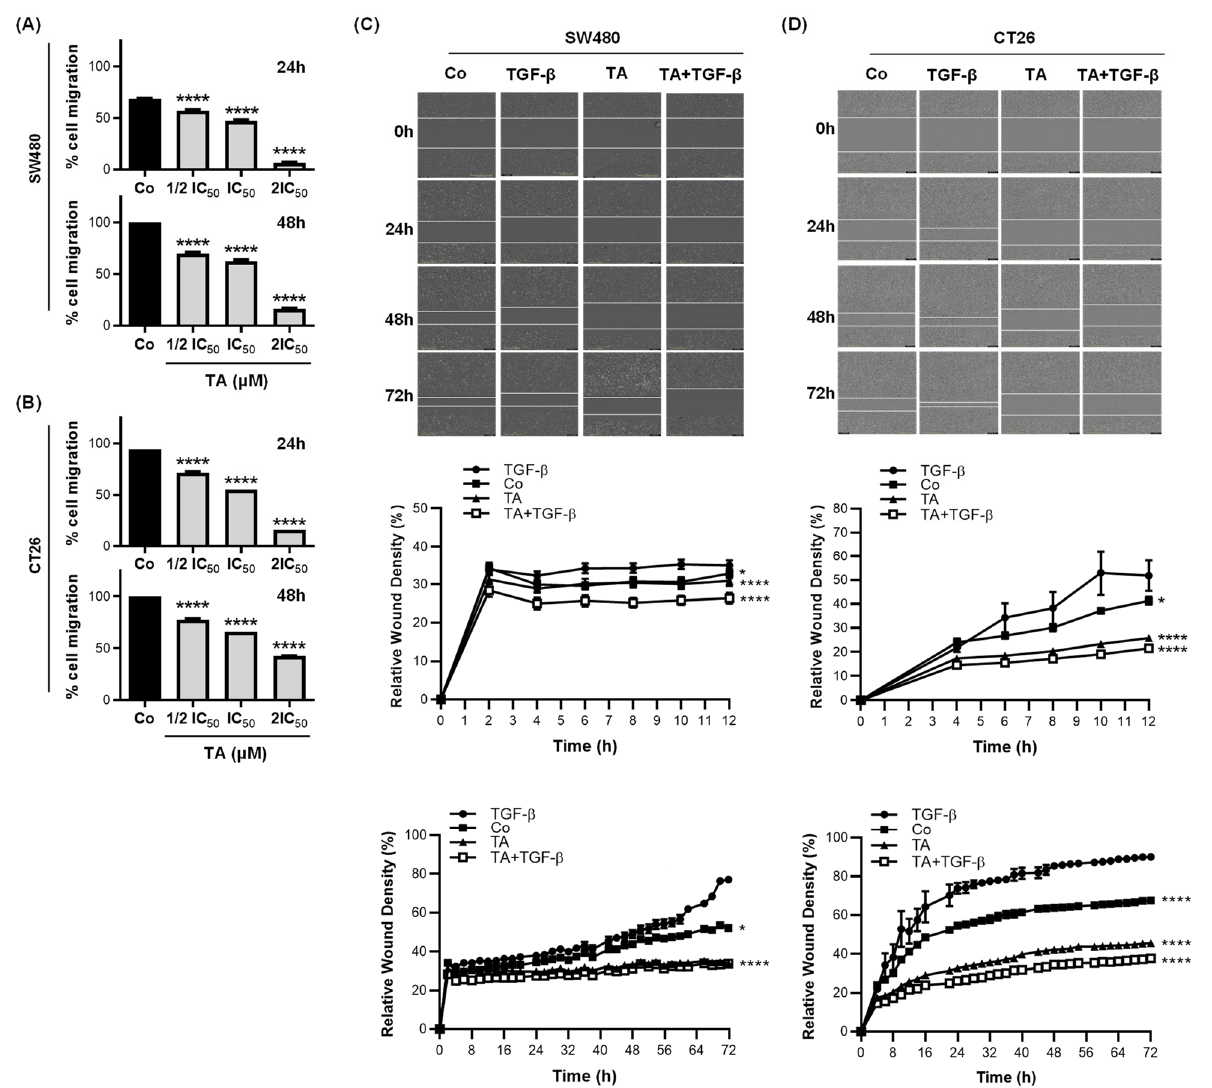
Figure 3. TA decreases the basal and TGF- β -induced migratory abilities of CRC cells. ( A , B ) Confluent SW480 and CT26 cell monolayers were subjected to scratch wounding and then cultured in RPMI medium with 0.5% FBS only (Control, Co), or in the presence of TA (SW480 cells: IC 50 = 12 µM, ½ IC 50 = 6 µM, and 2IC 50 = 24 µM; CT26 cells: IC 50 = 11 µM, ½ IC 50 = 5.5 µM, and 2IC 50 = 22 µM). The percentages of the wound recovery area at 24 h and 48 h, reflecting cell migration, were calculated as described in the Materials and Methods Section and are expressed as the mean ± SD of 3 experiments (n = 3) carried out in 3 replicates per condition. Statistical significance was determined by one-way ANOVA, followed by Tukey’s test for multiple comparison tests, with **** p ≤ 0.0001, vs. the corresponding control group. ( C , D ) Confluent SW480 and CT26 cell monolayers were subjected to scratch wounding and then cultured in RPMI medium with 0.5% FBS only (Control, Co), or in the presence of TA (0.8 µM), TGF- β (10 ng/mL), or TA and TGF- β (TA + TGF- β ). The percentages of the wound recovery area over time (up to 72 h), reflecting cell migration, were calculated as described in the Materials and Methods Section and are expressed as the mean ± SD of 3 experiments (n = 3) carried out in 3 replicates per condition. ( C , D , top panel). Representative photomicrographs (10× objective) of the wounds at 0 h (initial wounds), and at 24 h, 48 h, and 72 h were taken using the IncuCyte ® S3 Live-Cell Analysis System. The dotted lines represent the migration front lines. Statistical significance was determined by one-way ANOVA, followed by Tukey’s test for multiple comparison tests, with * p < 0.05, **** p < 0.0001, vs. TGF- β group.